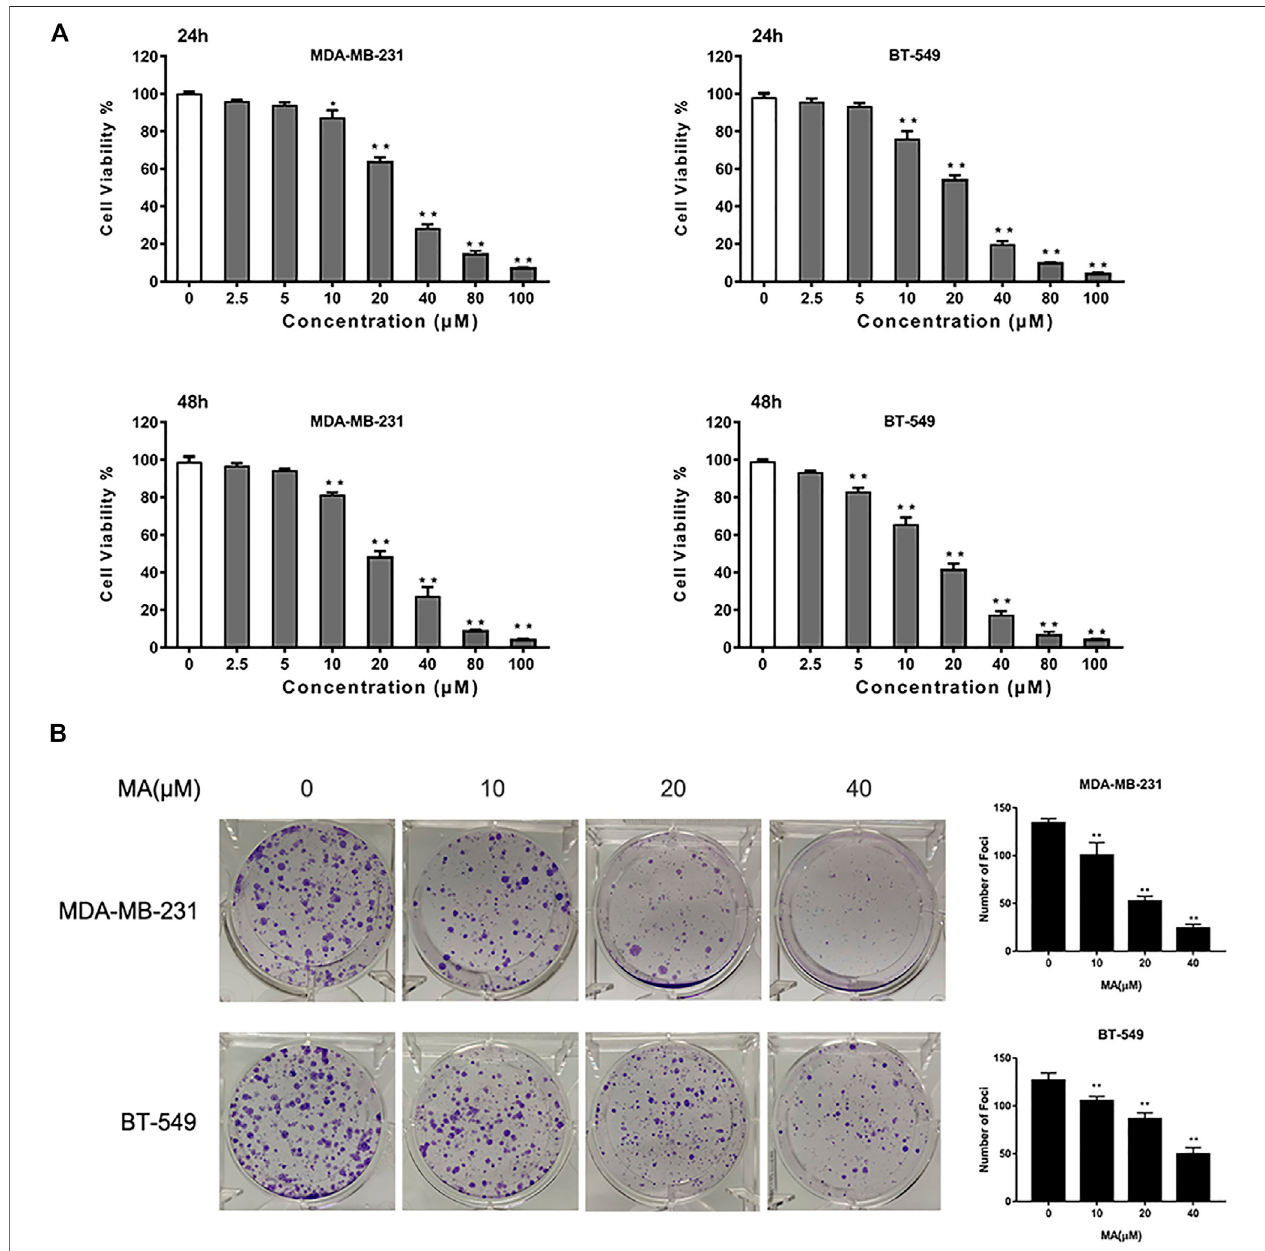
FIGURE 2 | MA attenuates TNBC cell growth. (A) Cell viability of TNBC cells after MA treatment. (B) Representative images and number of foci formation in TNBC cells after exposure to MA for 24 h. Compared with the control group (0 μ M), * p < 0.05, ** p < 0.01.